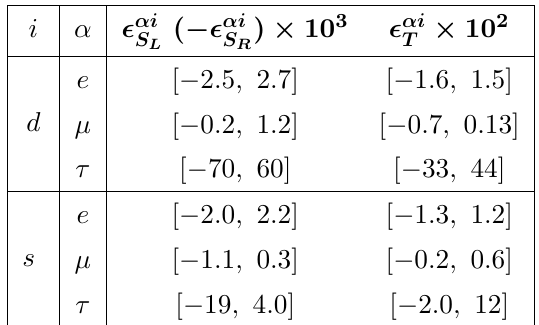
Table 3 . 95% CL ranges of the WCs, assumed to be real, obtained from D scalar and tensor operators in the chiral basis at µ = 1 TeV. The ranges of (cid:15) α